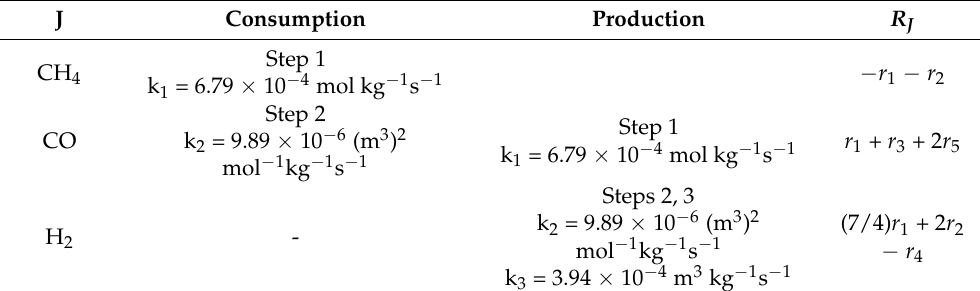
Table 8. Reaction rates of the combined reform of methane. Conditions: Ni (4.82 wt.%)/ γ -Al 2 O 3 , 1023 K, 1.0 bar